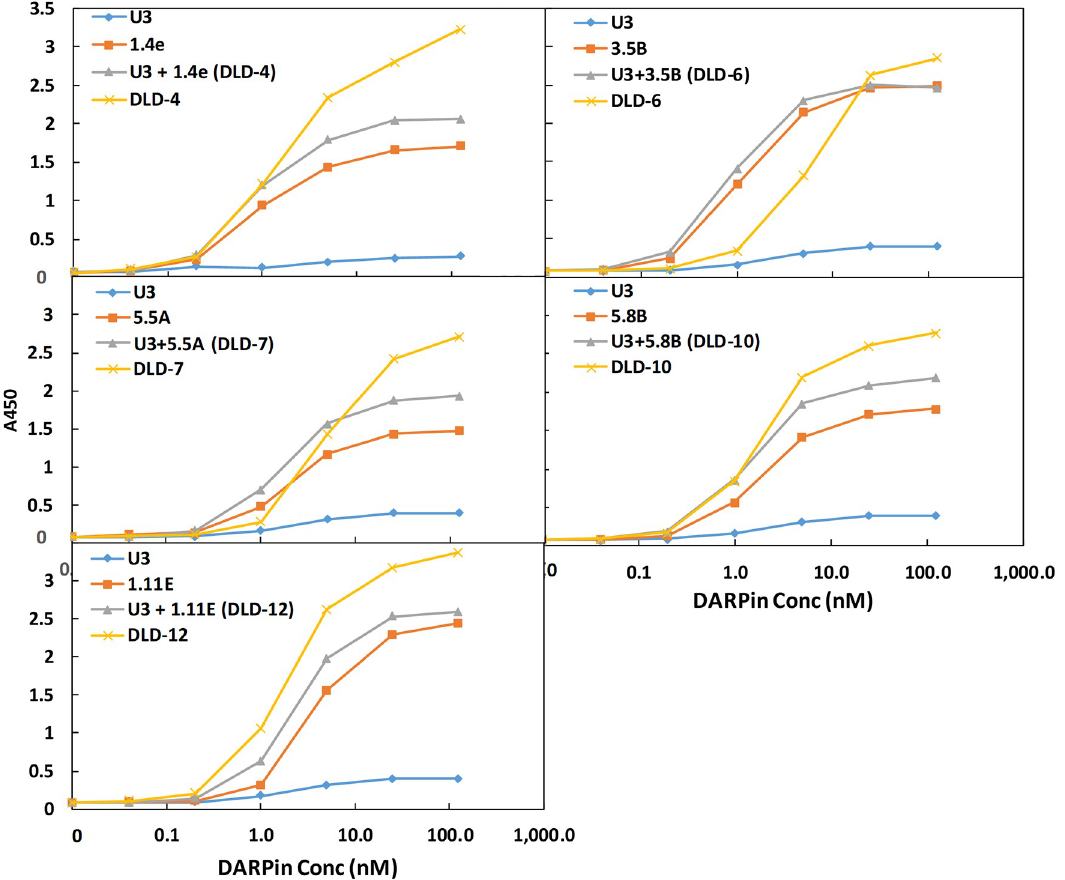
Fig 4. DARPin dimers demonstrate avidity in TcdB binding. Binding of selected DARPin monomers, pooled monomers, or dimers to TcdB was determined using ELISA. Combinations of serially diluted DARPins were added to microtiter plates coated with 4 μ g/mL of TcdB. Results are representative of 2 independent experiments. Conc, concentration; DARPin, designed ankyrin repeat protein; ELISA, enzyme-linked immunosorbent assay; TcdB, C . difficile toxin B.